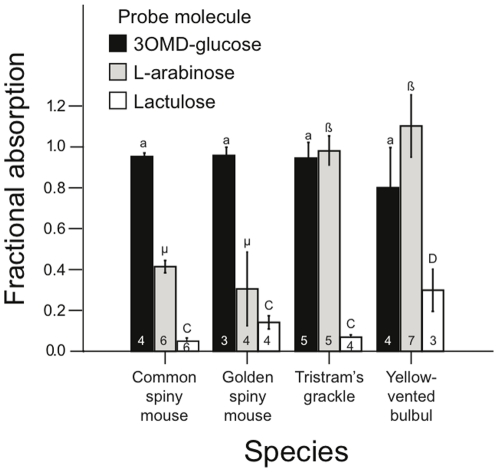
Comparison of fractional absorption of three probe molecules among four species.Means and SEM are shown, and sample sizes are the numbers within each of the bars. For each probe type, where bars are accompanied by common letters, the means did not differ significantly based on statistical analyses described in Results. Thus, all species absorbed 3OMD-glucose to the same high extent, arabinose absorption was significantly higher in the bird species than in the rodent species, and lactulose absorption was low in all the species but, among them, slightly higher in yellow-vented bulbuls.